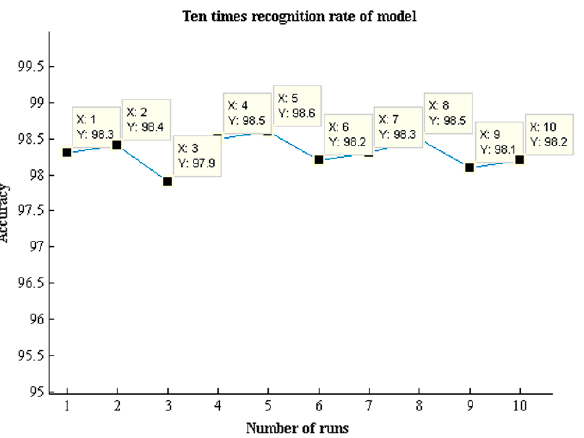
Figure 10. Average recognition accuracy by the proposed multi-model feature fusion model.